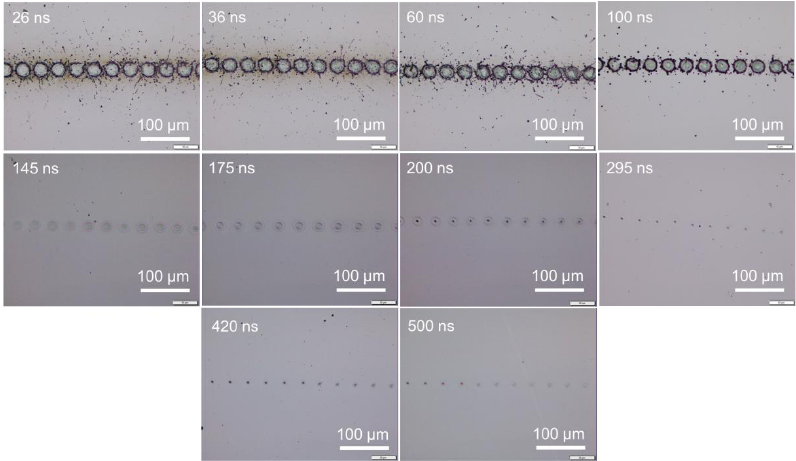
Figure 3. Optical images of irradiated silicon surfaces with 0.08 mJ pulse energy (10.24 J/cm 2 ) at a scanning speed of 5000 mm/s.